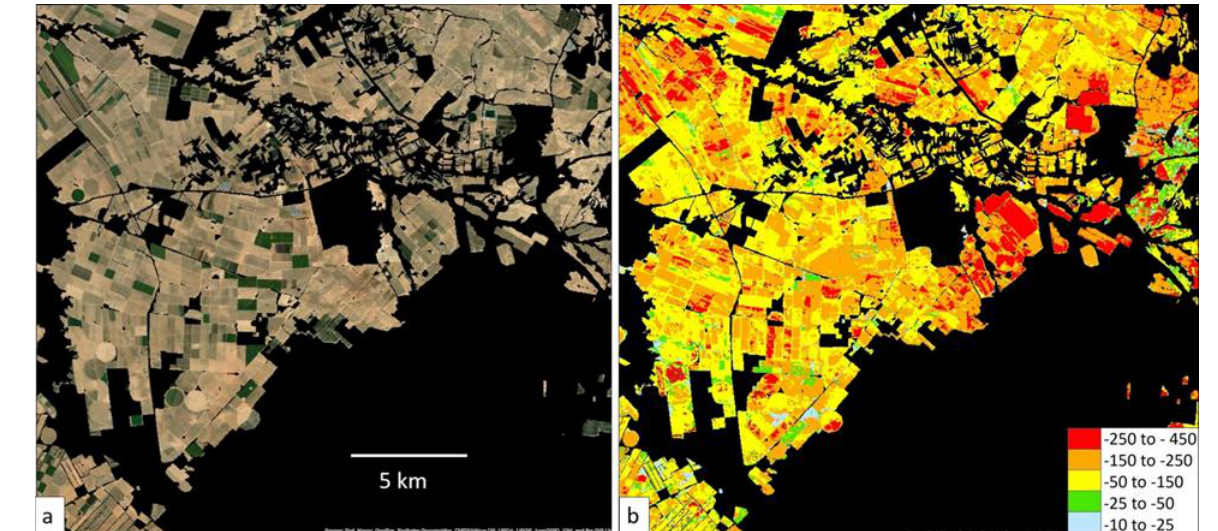
Figure 10. Intensive rainfed and irrigated cultivation NE of Hatzerim Air Base (31°17′ N, 34°36′ E). ( a ) True color image; ( b ) LNS diff (gC m −2 yr −1 ).